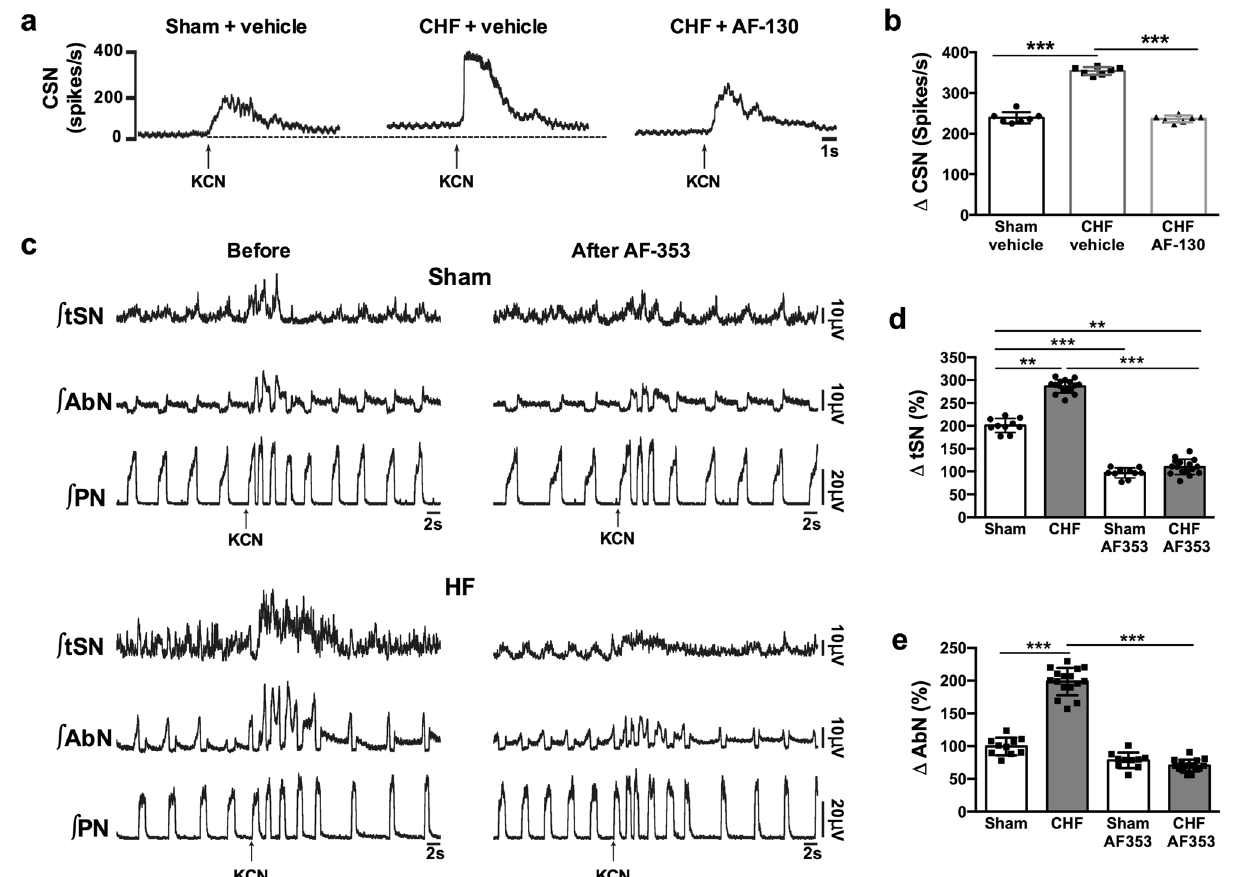
Fig. 4 | Carotid body P2X3-receptors mediate afferent hypersensitivity and chemore fl ex hyperre fl exia in heart failure (HF) rats. a Integrated ( ∫ ) recordings of carotid sinus nerve (CSN) activity during activation of peripheral chemor- eceptors(potassiumcyanide-KCN;0.05ml,i.v.,0.05%)inanaesthetizedrats.Note presence of elevated tonicity (relative to sham and dotted line) and augmented evoked response in CSN b in the chronic HF (CHF) rats and that these were both normalized after P2X3 receptor blockade ( a , b ; drug was given systemically). Data areshownasmean±SDandweretestedfornormality(Kolmogorov – Smirnovtest)